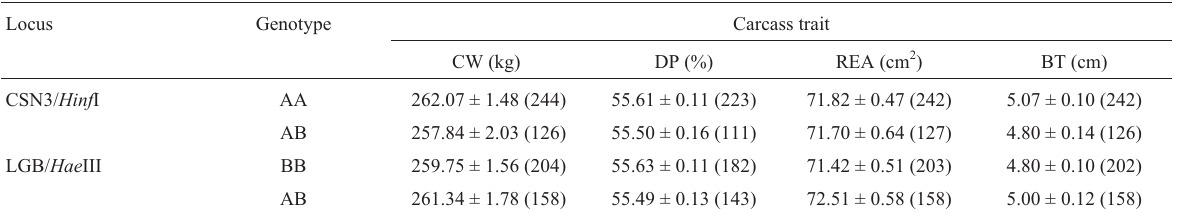
CW = carcass weight; DP = dressing percentage; REA = ribeye area; BT = backfat thickness. No significant differences were observed between genotypes (p >